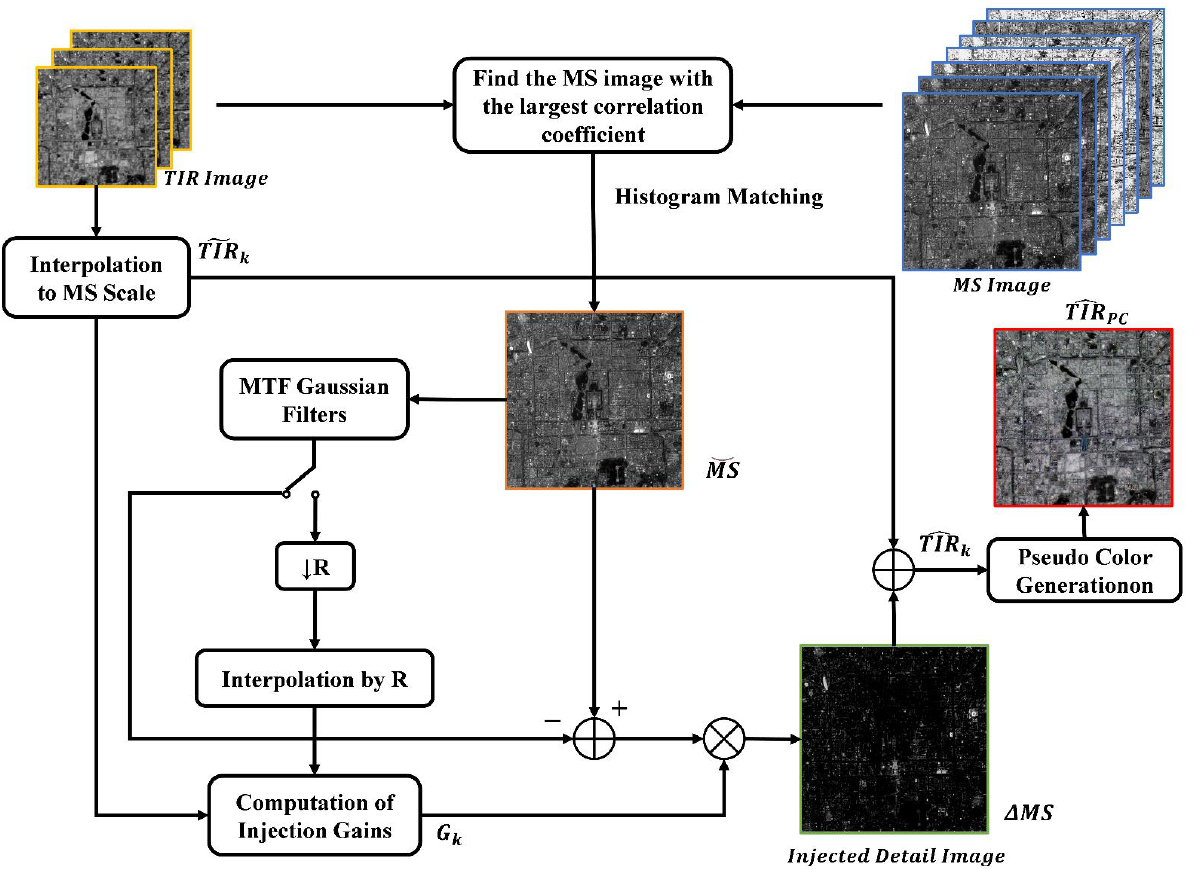
Figure 1. The entire flow chart of the proposed algorithm, where MS image indicates multispectral image and TIR image indicates thermal infrared image. Circles with a straight or diagonal cross in the middle indicate additive binding or multiplicative injection, respectively.